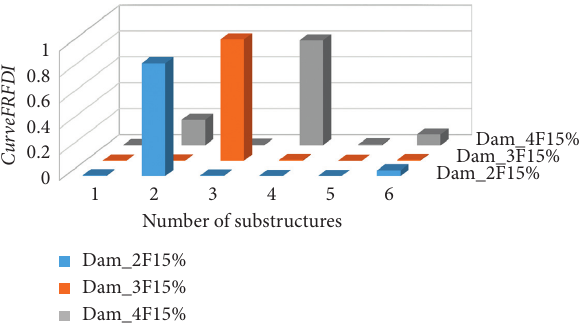
Figure 16: CurveFRFDI values for cases Dam_2F15%, Dam_3F15%, and Dam_4F15%.